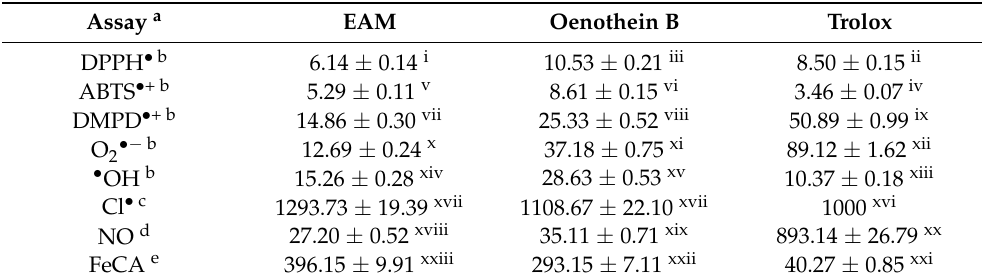
Table 6. The antioxidant activity of E. angustifolium melanoidin (EAM), oenothein B, and Trolox in eight in vitro